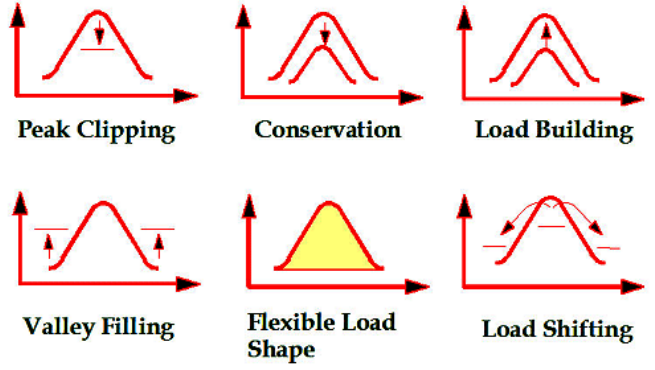
Fig. 1. Demand Side Management strategies